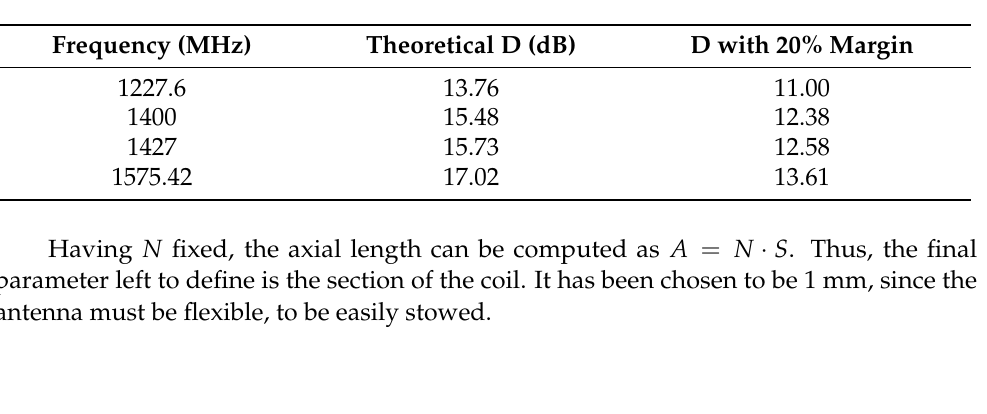
Table 4. Calculated theoretical